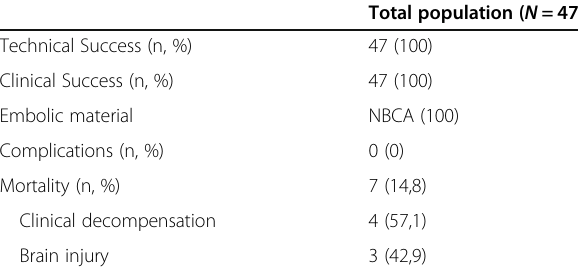
Table 3 Procedures and